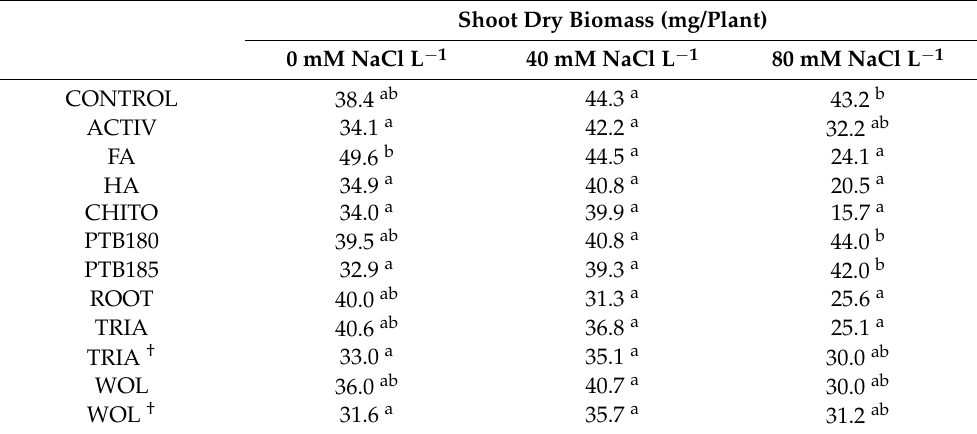
Table 7. Effect of biostimulants and salinity levels on the shoot dry biomass of baby leaf lettuce plants under conventional management.